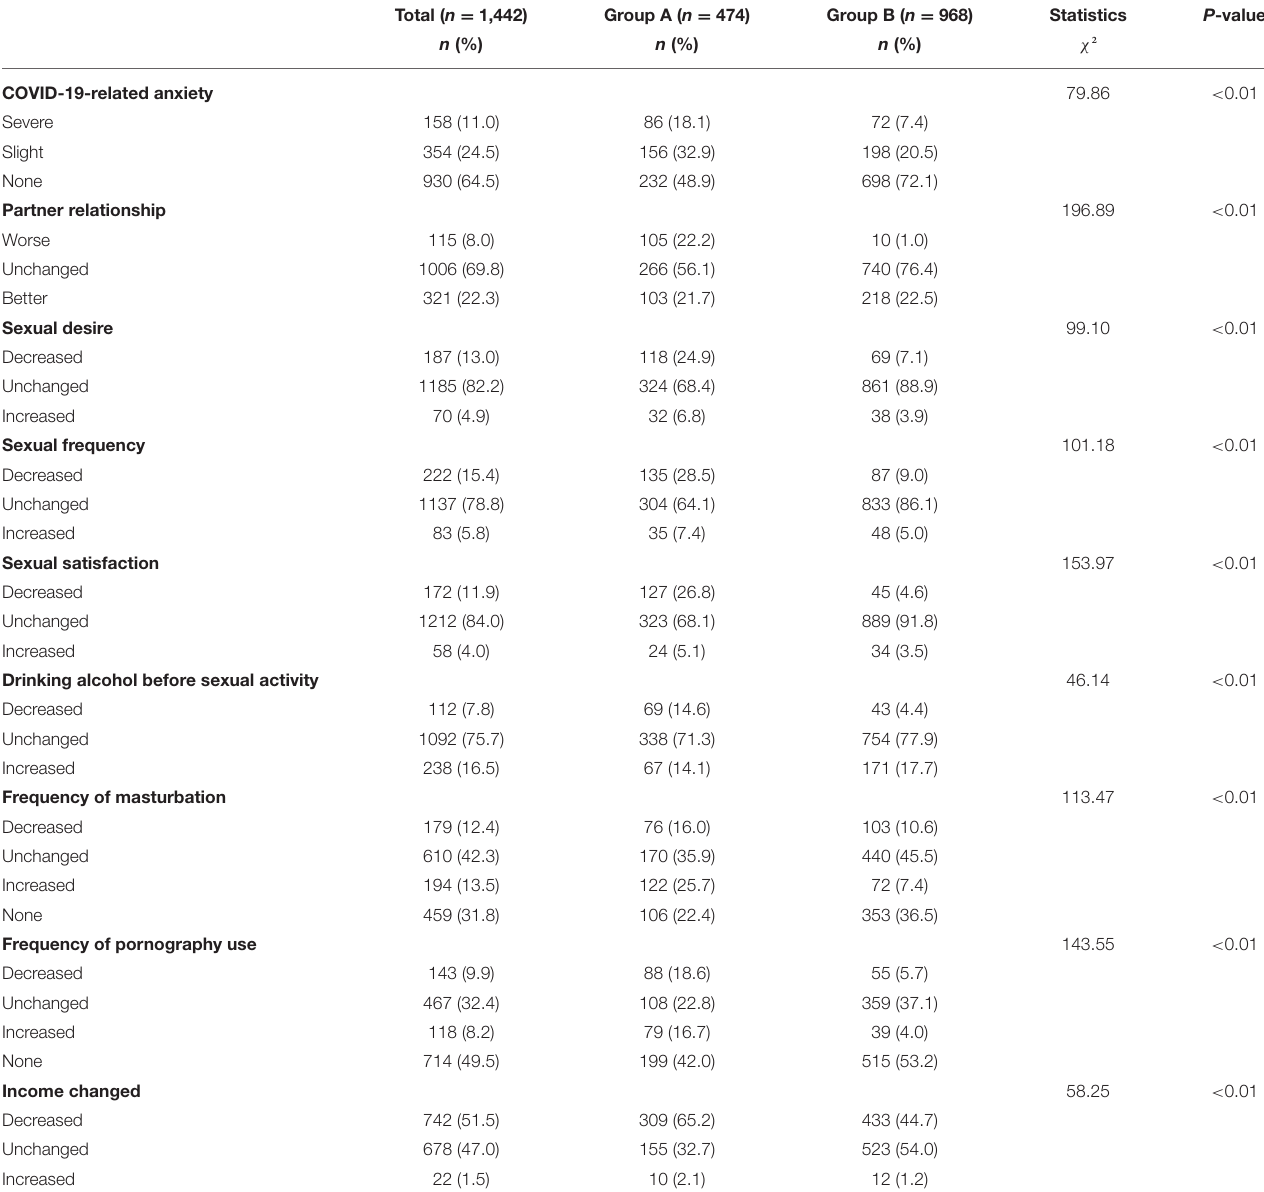
TABLE 2 | COVID-19-related impact on infertile